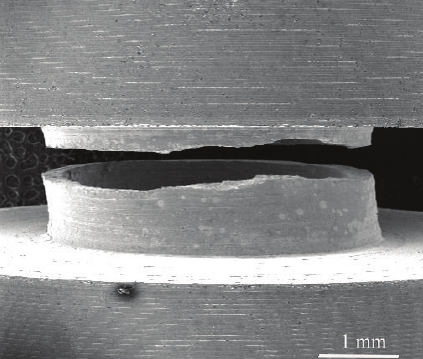
Figure 5: Micrographs (SEM) of specimens fractured at strain rate of 2600 s −1 and temperature of 25 ∘